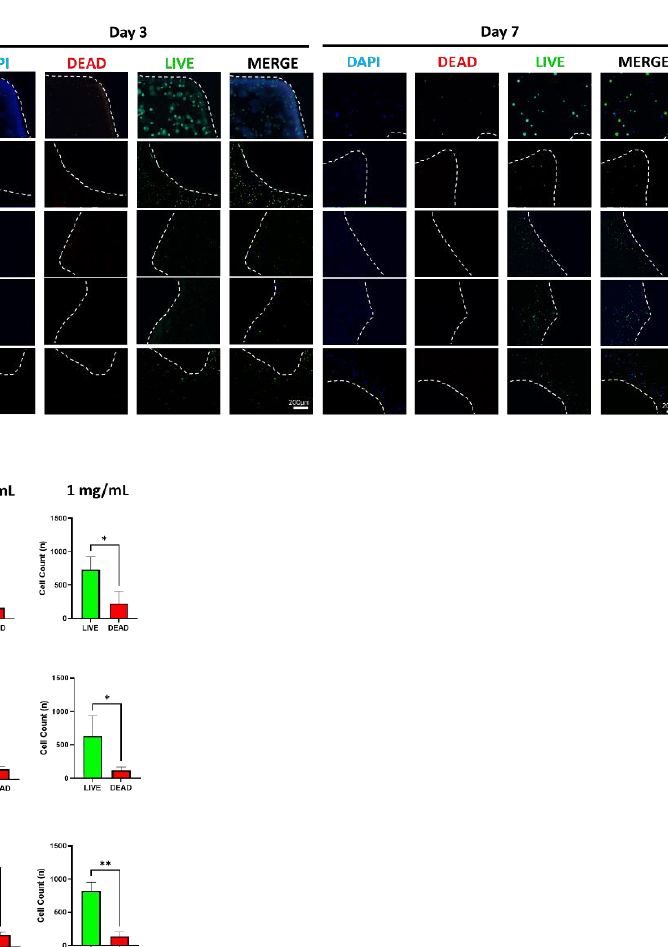
Figure 7. ( a ) Raman microscopy confocal images of scaffolds printed with cells. Cells are dispersed throughout the scaffolds homogenously. White arrows indicate cells embedded on the scaffold sur-